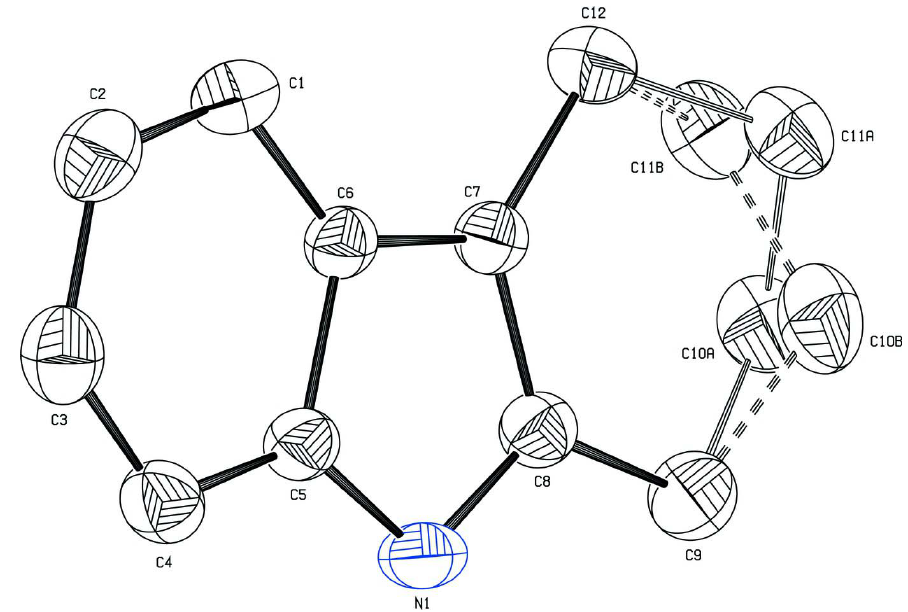
The molecular structure of title compound, showing 30% probability displacement ellipsoids. Both disorder components are